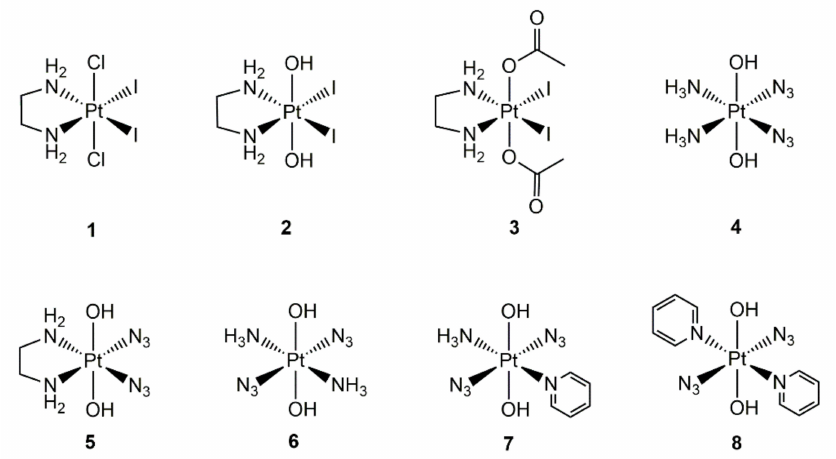
Figure 2. Chemical structures of iodoplatinum(IV)–amines 1 – 3 and diazido Pt(IV) complexes 4 –